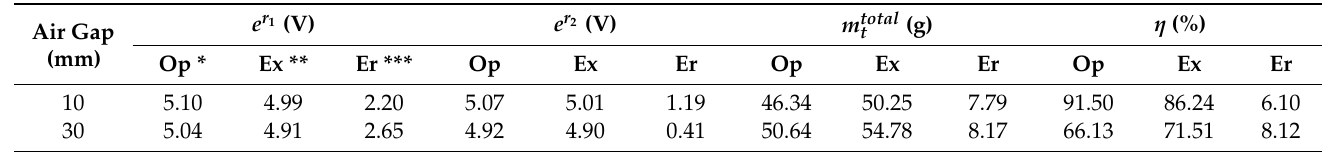
Table 3. Comparison between the proposed optimization and